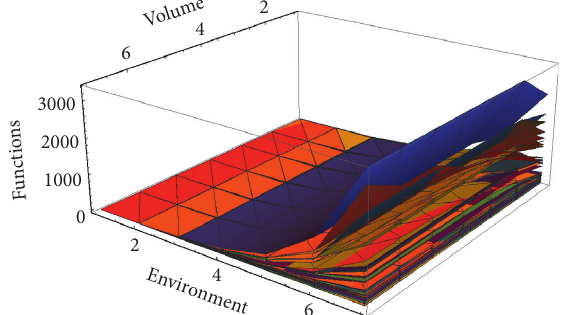
Figure 5: All rules for which the number of functions induced by a fixed environment thickness increases not only from volume size 1 to 2 and never decreases with increasing volume size.